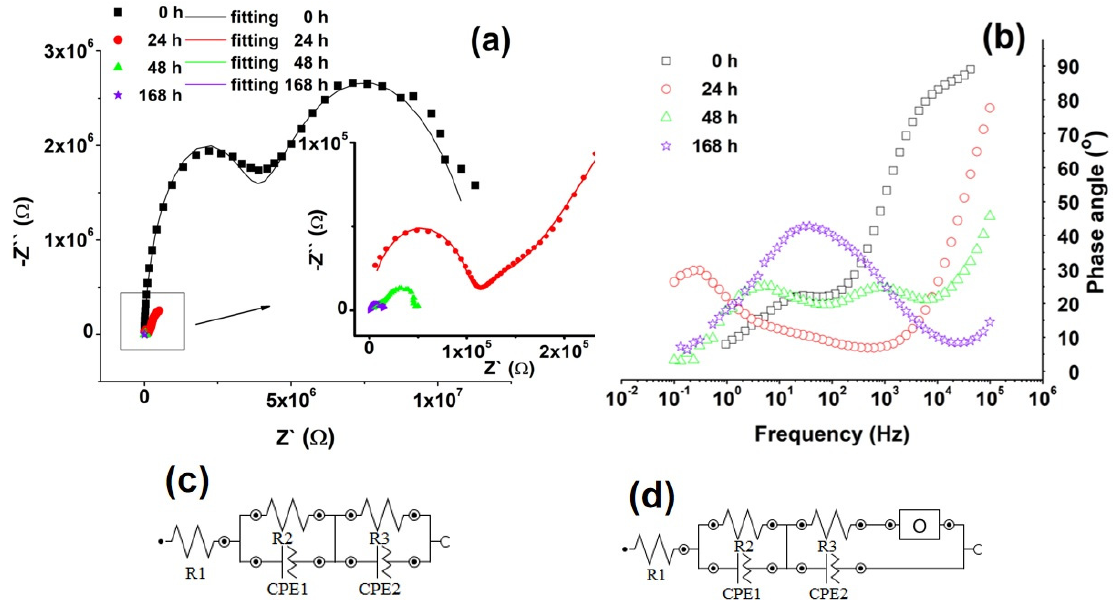
Figure 6. Nyquist ( a ), Bode ( b ) diagrams, and ( c ) equivalent circuit from 0 h, ( d ) equivalent circuit from 24–168 h of Mg alloy-PLA, immersed in SBF, over time.